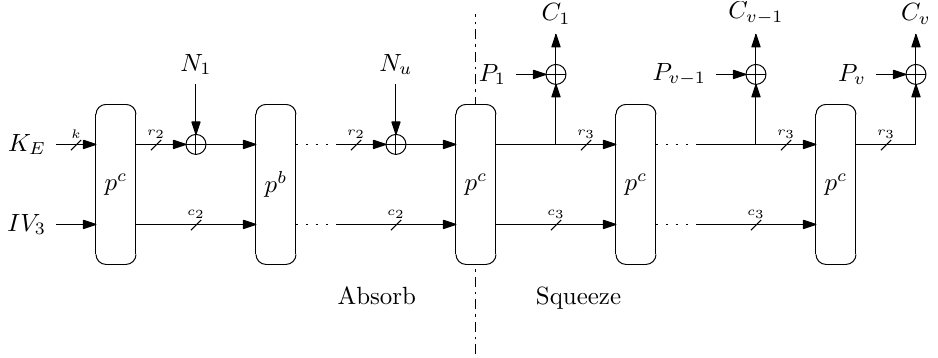
Figure 4: IsapEnc used for